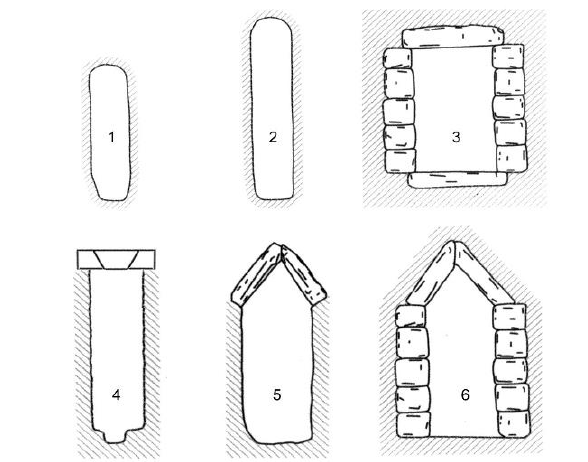
Figure 13 . Graphic restitution of the different types of hypogeal